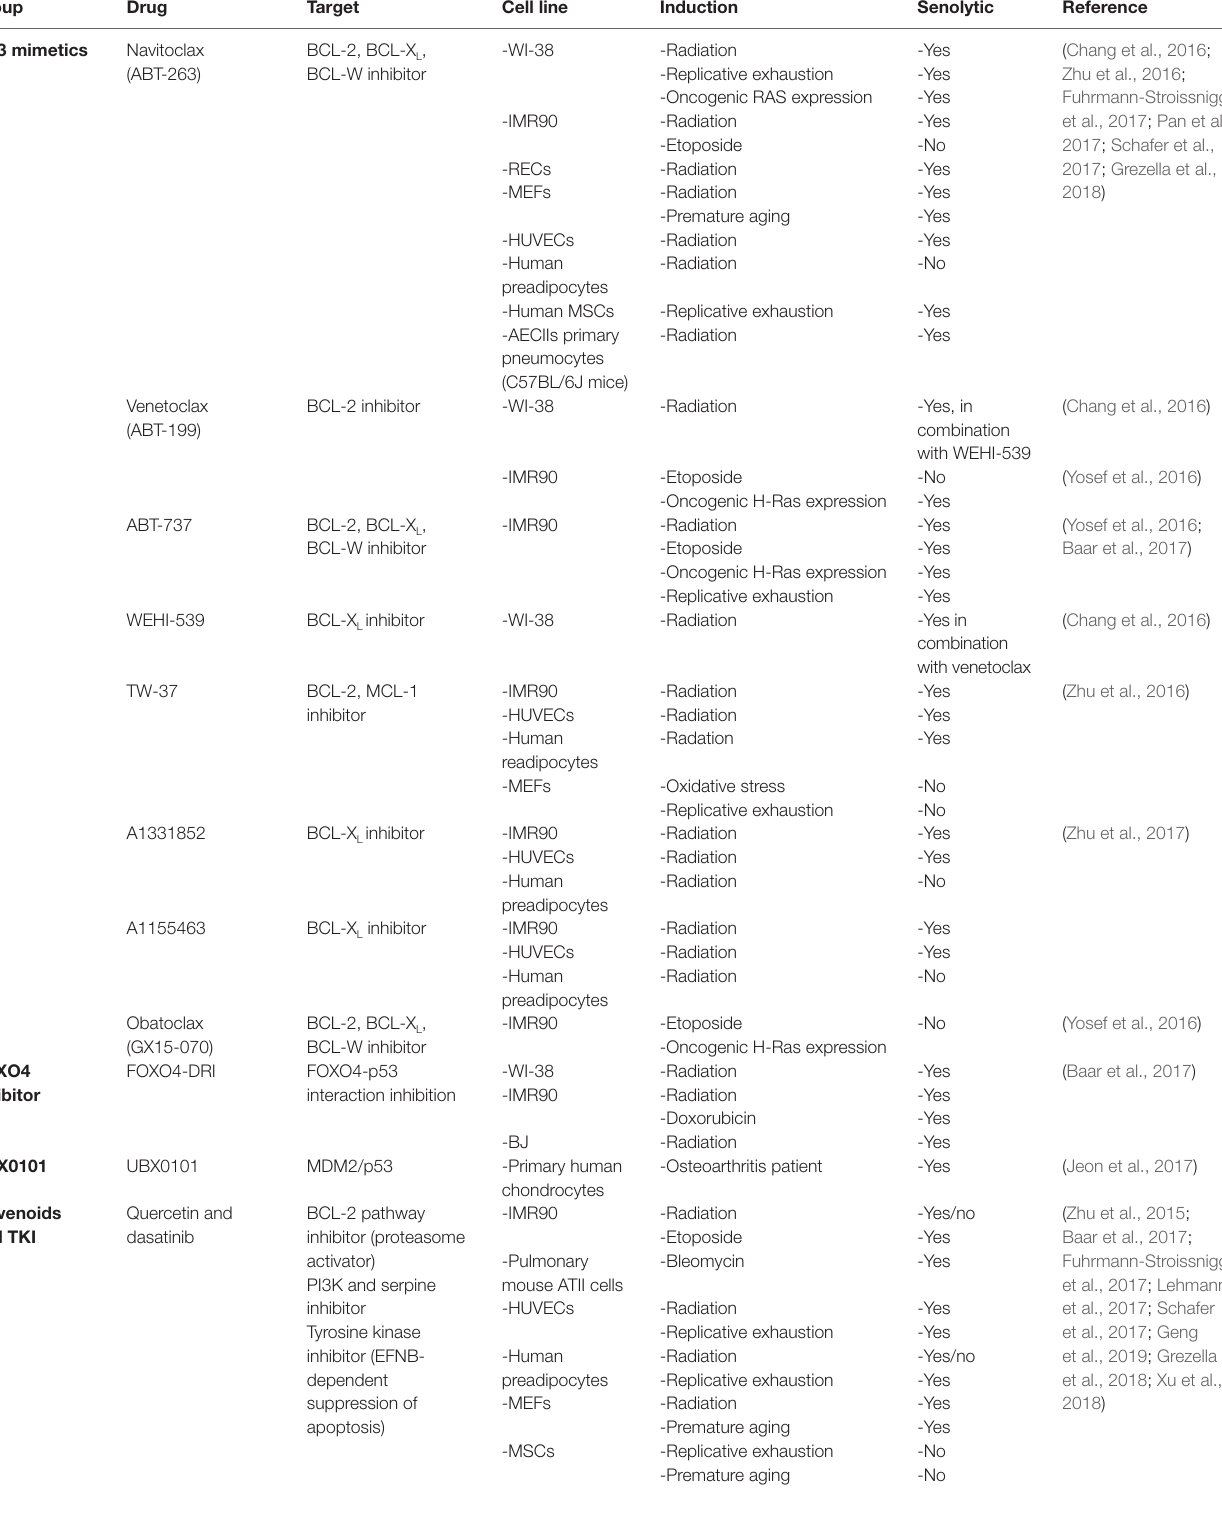
TABLE 4 | In vitro senolytic effect of tested drugs on different cell lines and different manners of senescence induction.